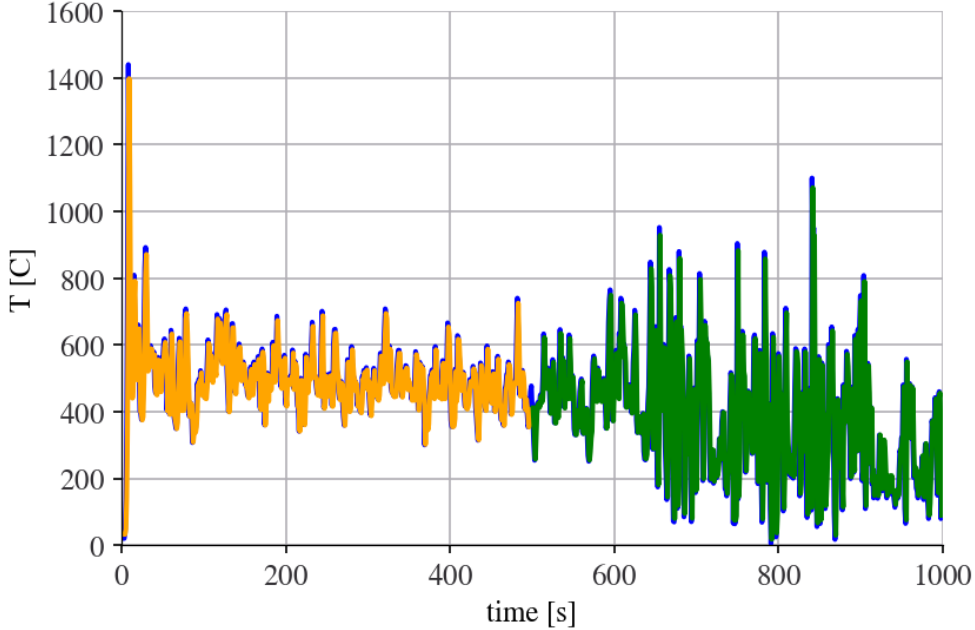
Figure 10. Prediction of the temperature reading using a simple multilayer perceptron model with a time lag, blue represents the whole dataset, green represents training and orange represents predictions.